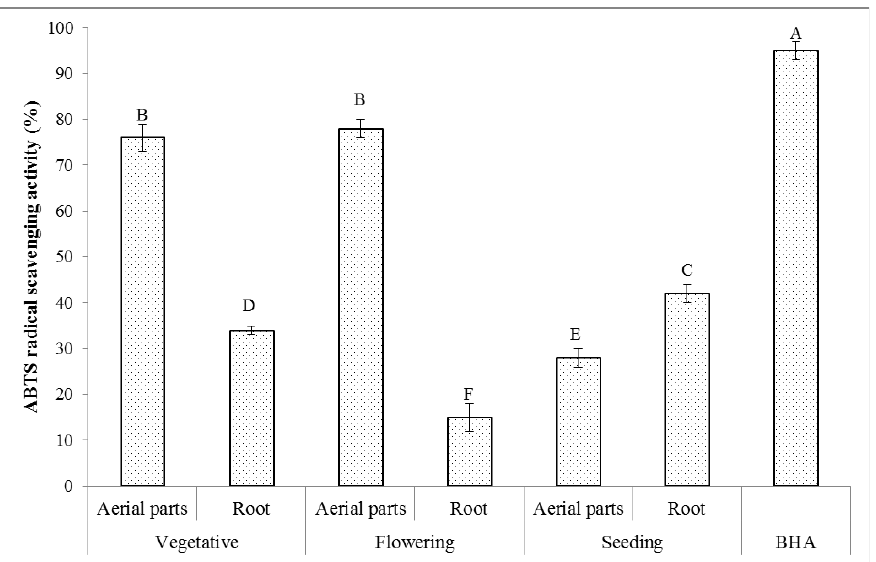
Figure 3. ABTS radical scavenging activity ( n = 3) of the extracts of the T. polium aerial parts and root at different phenological stages. The extract concentration is 200 µg/mL. Various letters indicate statistically significant differences ( p < 0.05).